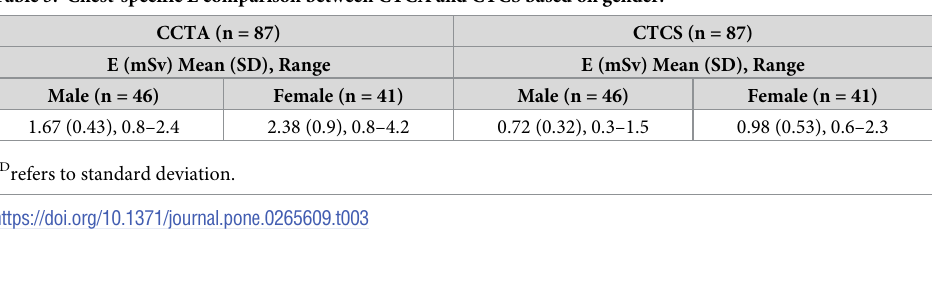
Table 3. Chest-specific E comparison between CTCA and CTCS based on gender.